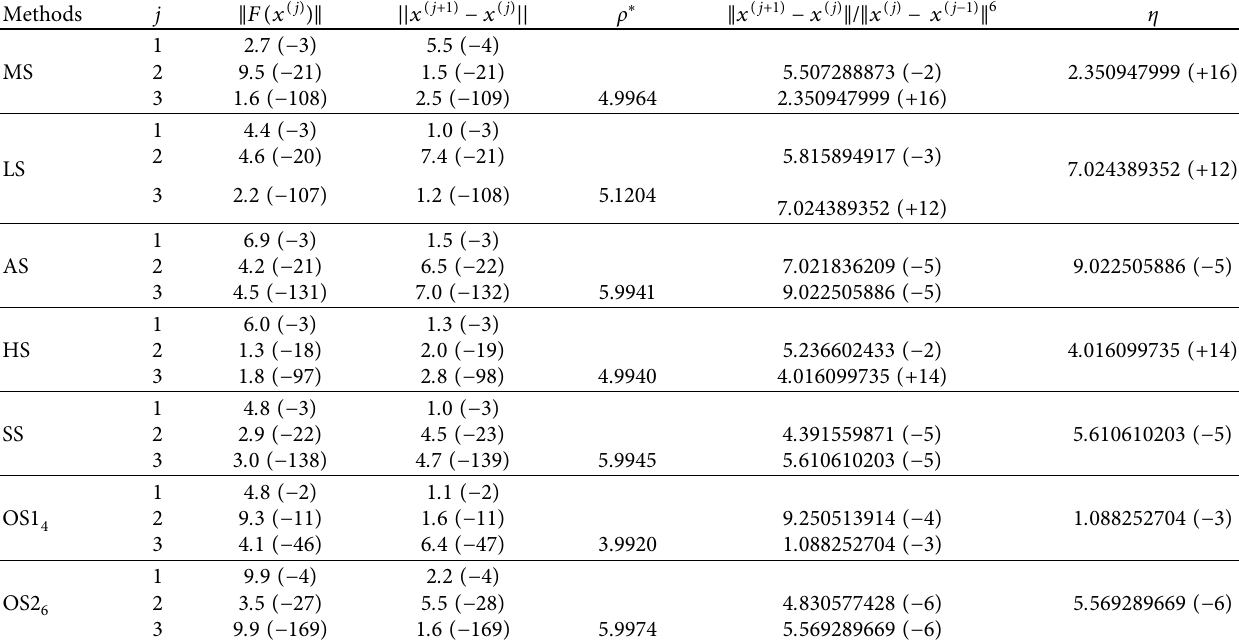
Table 2: Convergence behavior of different methods on Fisher’s equation